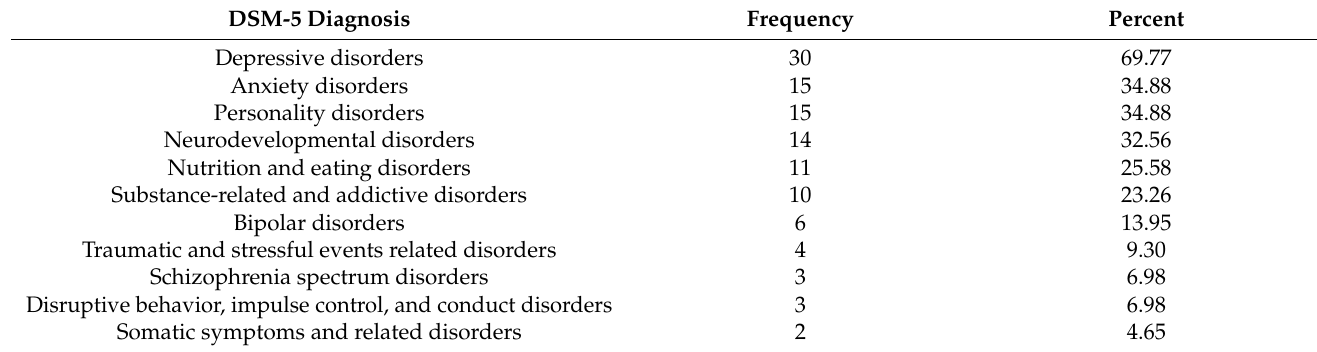
Table 1. Diagnostic and Statistical Manual of Mental Disorders Fifth Edition (DSM-5) diagnosis of the sample.